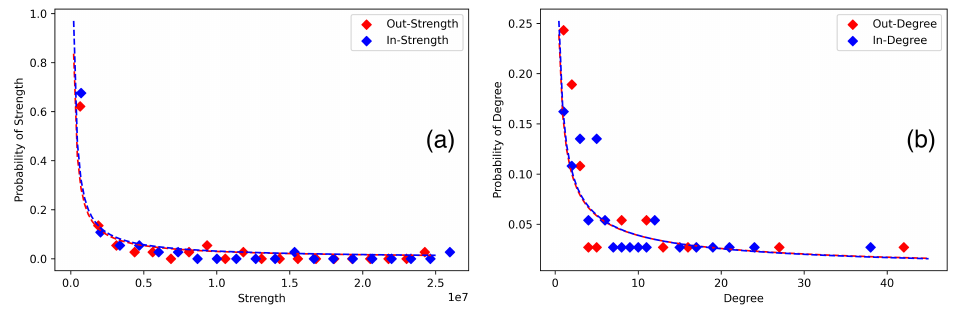
Figure 5. The strength ( a ) and degree ( b ) distributions for fossil fuels energy trade in